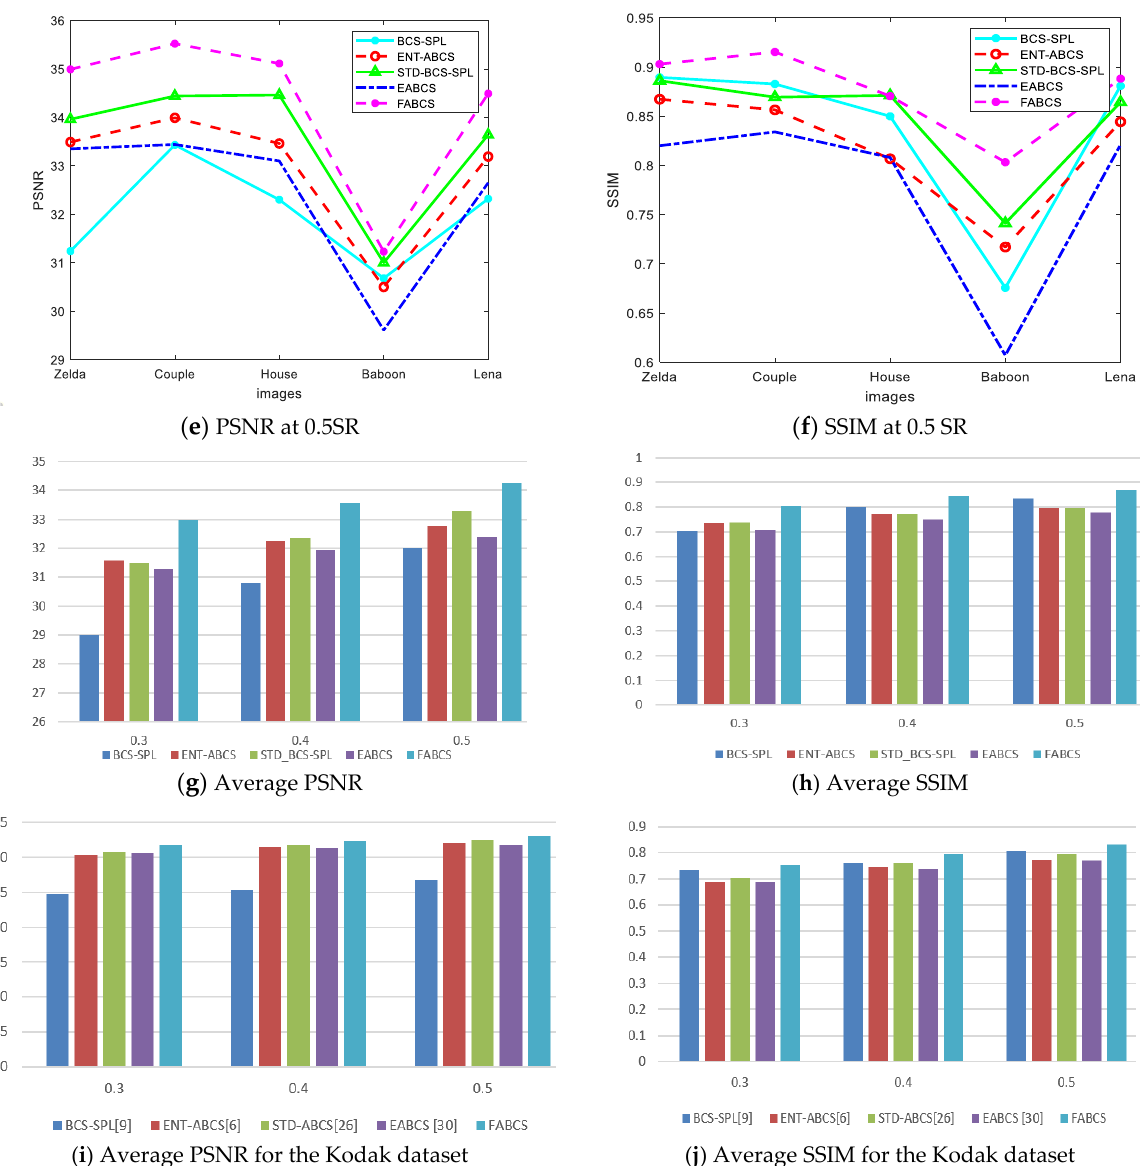
Figure 6. ( a – f ) Performance comparison of different algorithms on Standard images and ( g , h ), ( i , j ) average PSNR and SSIM for standard images and Kodak dataset images.